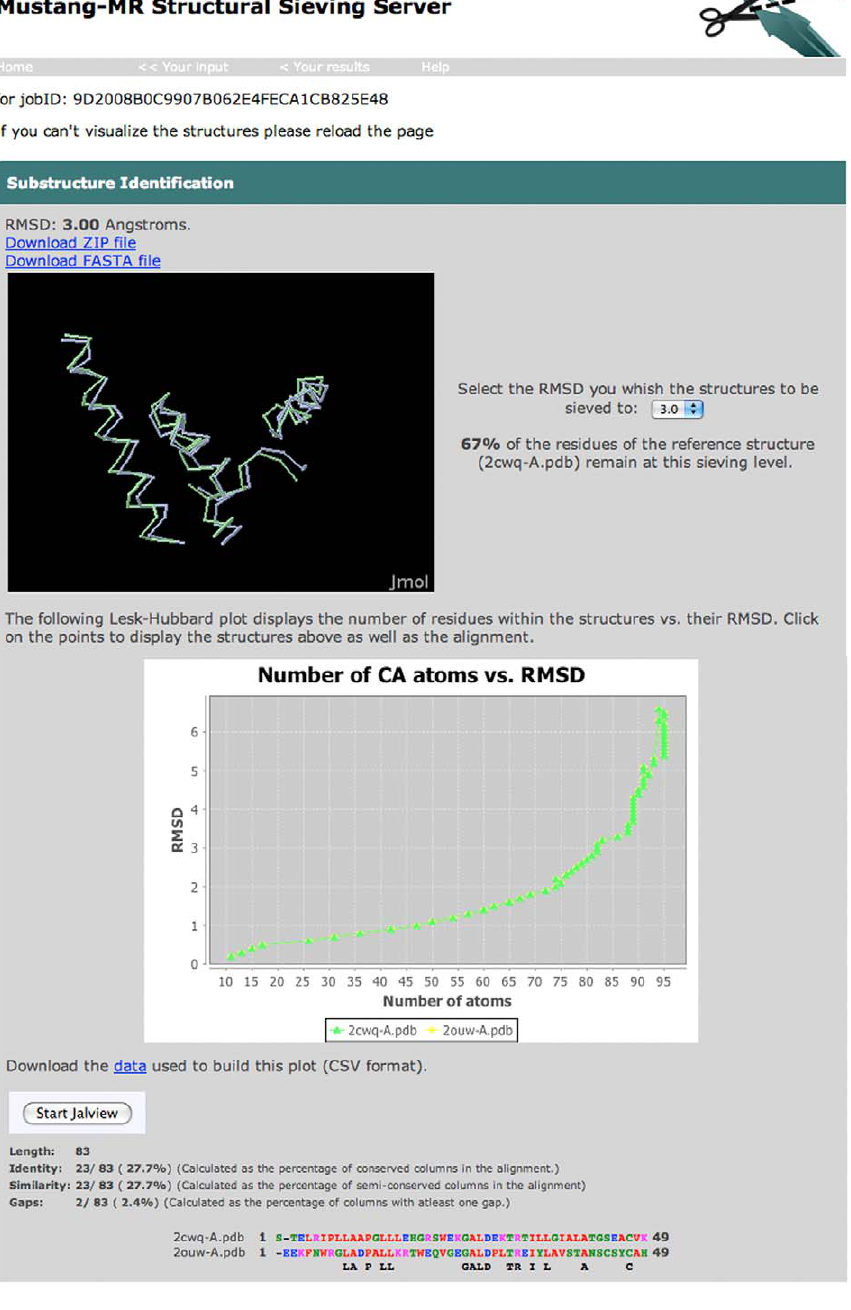
Figure 2. Screen snapshot of the results of a typical structural alignment, showing the sieving results in a Jmol window, Lesk- Hubbard plot, and structure-based sequence alignment.